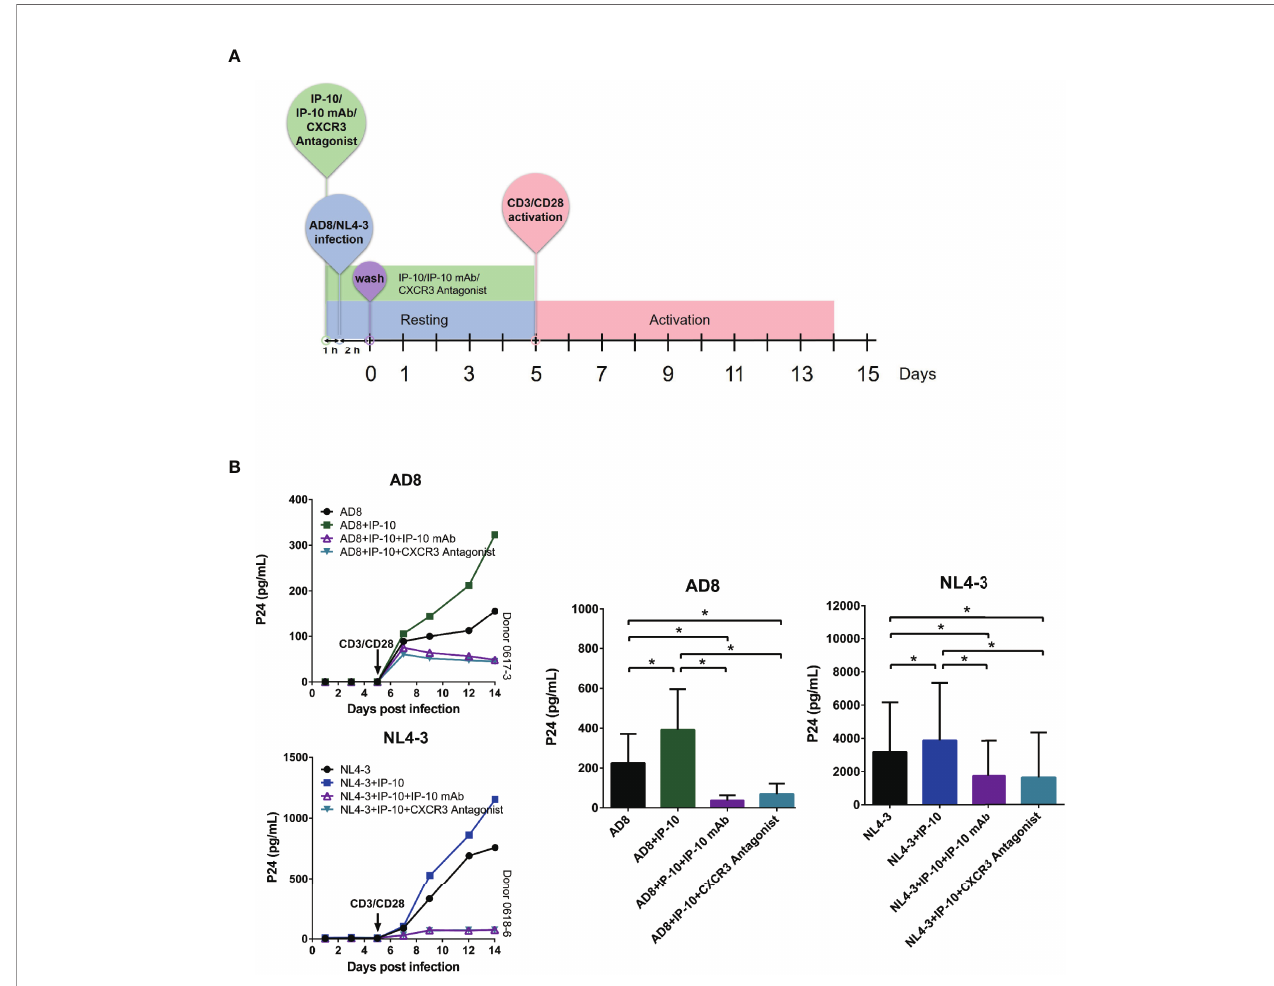
FIGURE 3 | IP-10 promotes HIV AD8 and NL4-3 infection of resting memory CD4 + T cells at the resting state. (A) Schematic illustration of the procedure for evaluating the role of IP-10 in HIV infection of resting memory CD4 + T cells at the resting state. (B) Kinetics of the effect of AD8(n = 7)/NL4-3(n = 8), AD8/NL4-3+IP- 10, AD8/NL4-3+IP-10+mAb, and AD8/NL4-3+IP-10+CXCR3 on resting memory CD4 + T cell at resting state from 2 representative NCs. P24 levels were compared between groups on the 14 th day post infection by one-way analysis of variance. * P <